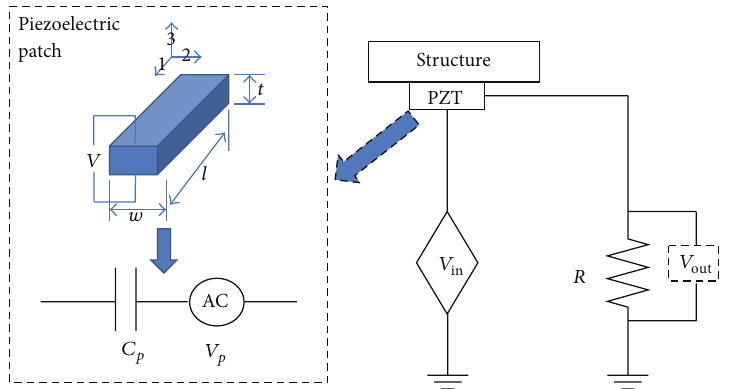
Figure 8: Diagram of PZT-structure bonded system.